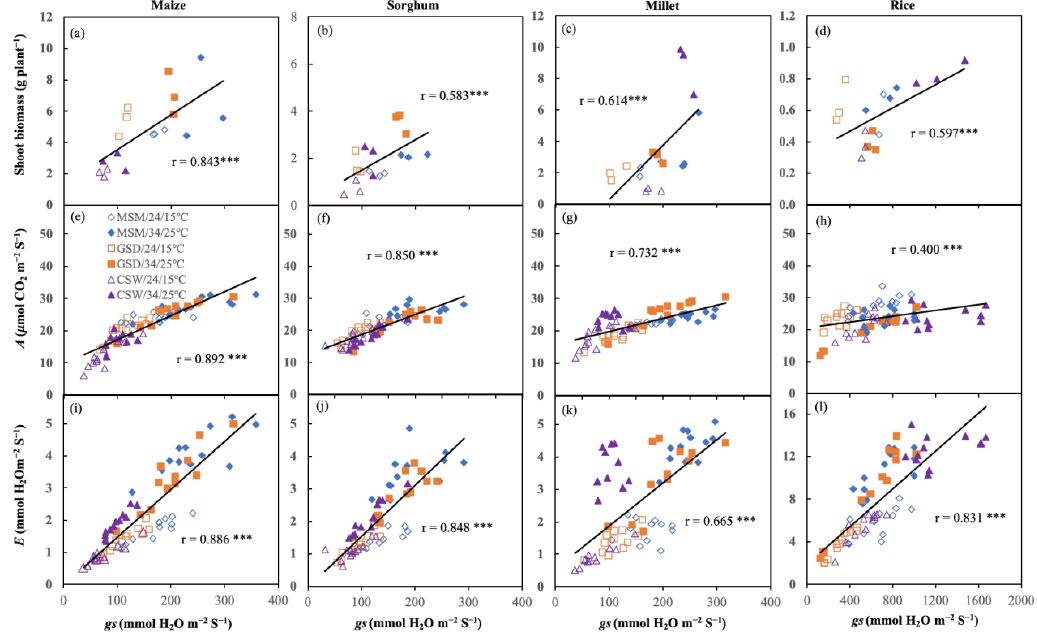
Figure 6. Correlation between stomatal conductance ( gs ), shoot biomass ( a – d ), and photosynthesis rate ( A ; e – h ), and transpiration rate ( E ; i – l ) in maize ( a , e , i ), sorghum ( b , f , j ), millet ( c , g , k )), and rice ( d , h , l ). *** indicates Pearson statistical significance at p < 0.001 ( n = 18 for shoot biomass and n = 72 for A and E ).